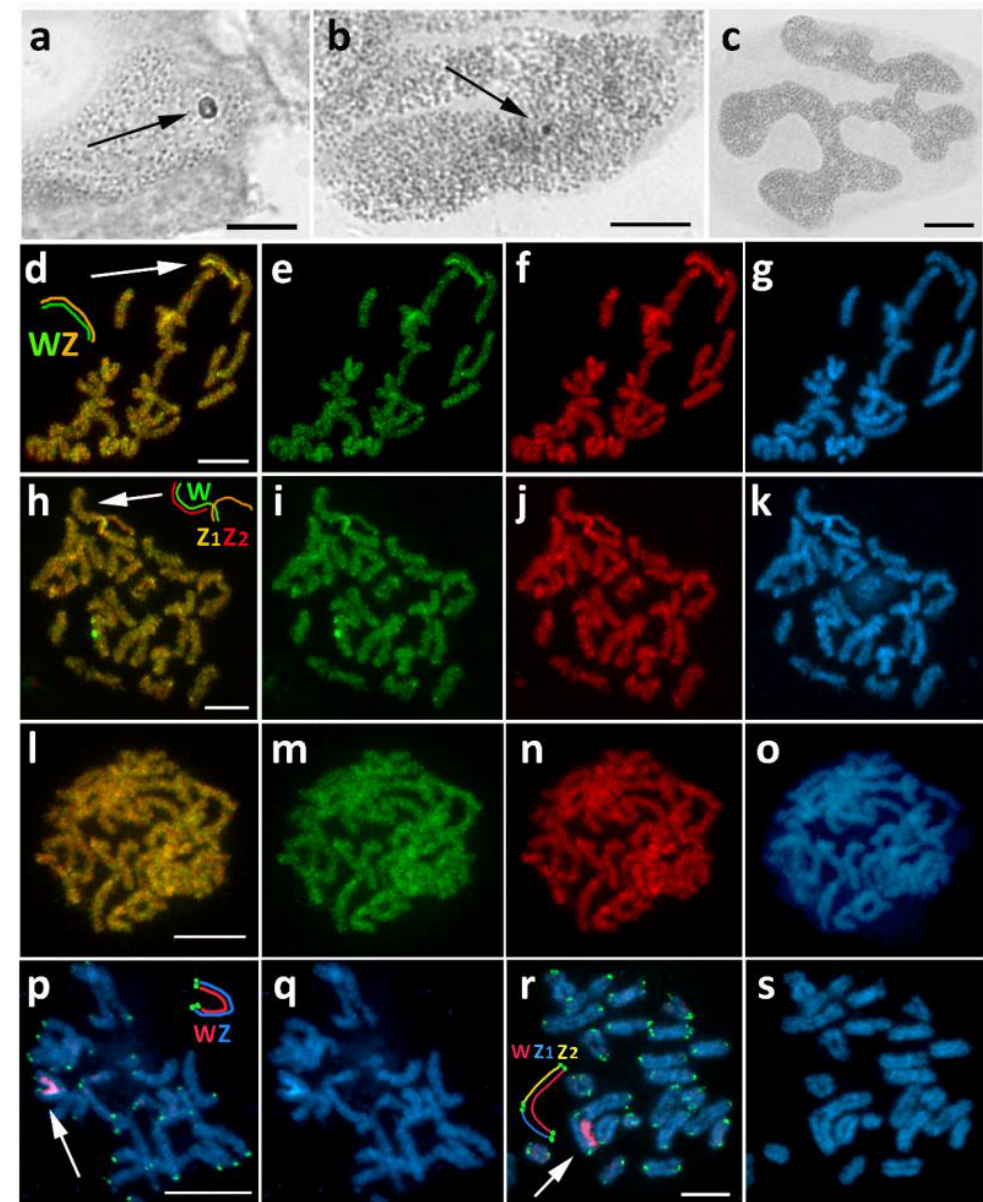
Figure 3. Sex chromosome systems in Chiasmia clathrata . ( a – c ) Polyploid nuclei stained with orcein showing a variable sex chromatin pattern in females from different broods, either normal ( a ) or min- iature body ( b ), whereas it is absent in males ( c ). ( d – o ) Comparative genomeic hybridization (CGH) on pachytene chromosomes revealed a WZ sex chromosome bivalent (arrow and schematic drawing in d ) in females with normal sex chromatin ( d – g ) and a WZ 1 Z 2 trivalent (arrow and schematic draw- ing in h ) in females with scattered sex chromatin ( h – k ); no chromosome was differentiated by CGH